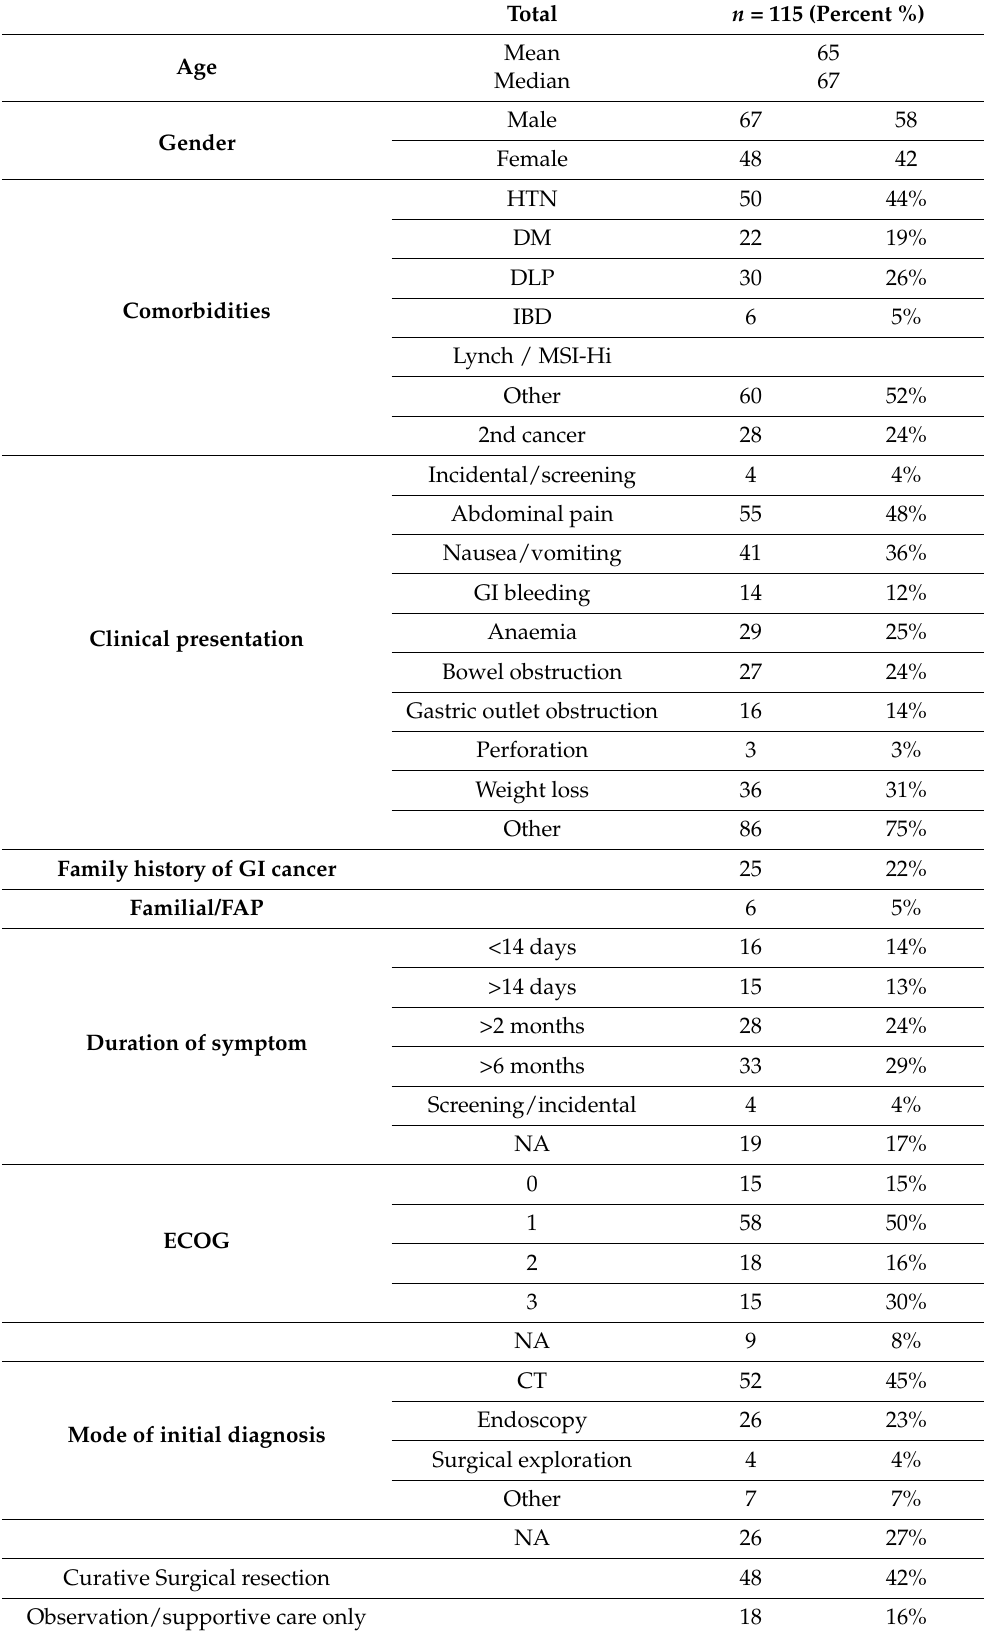
Table 1. Baseline patient’s